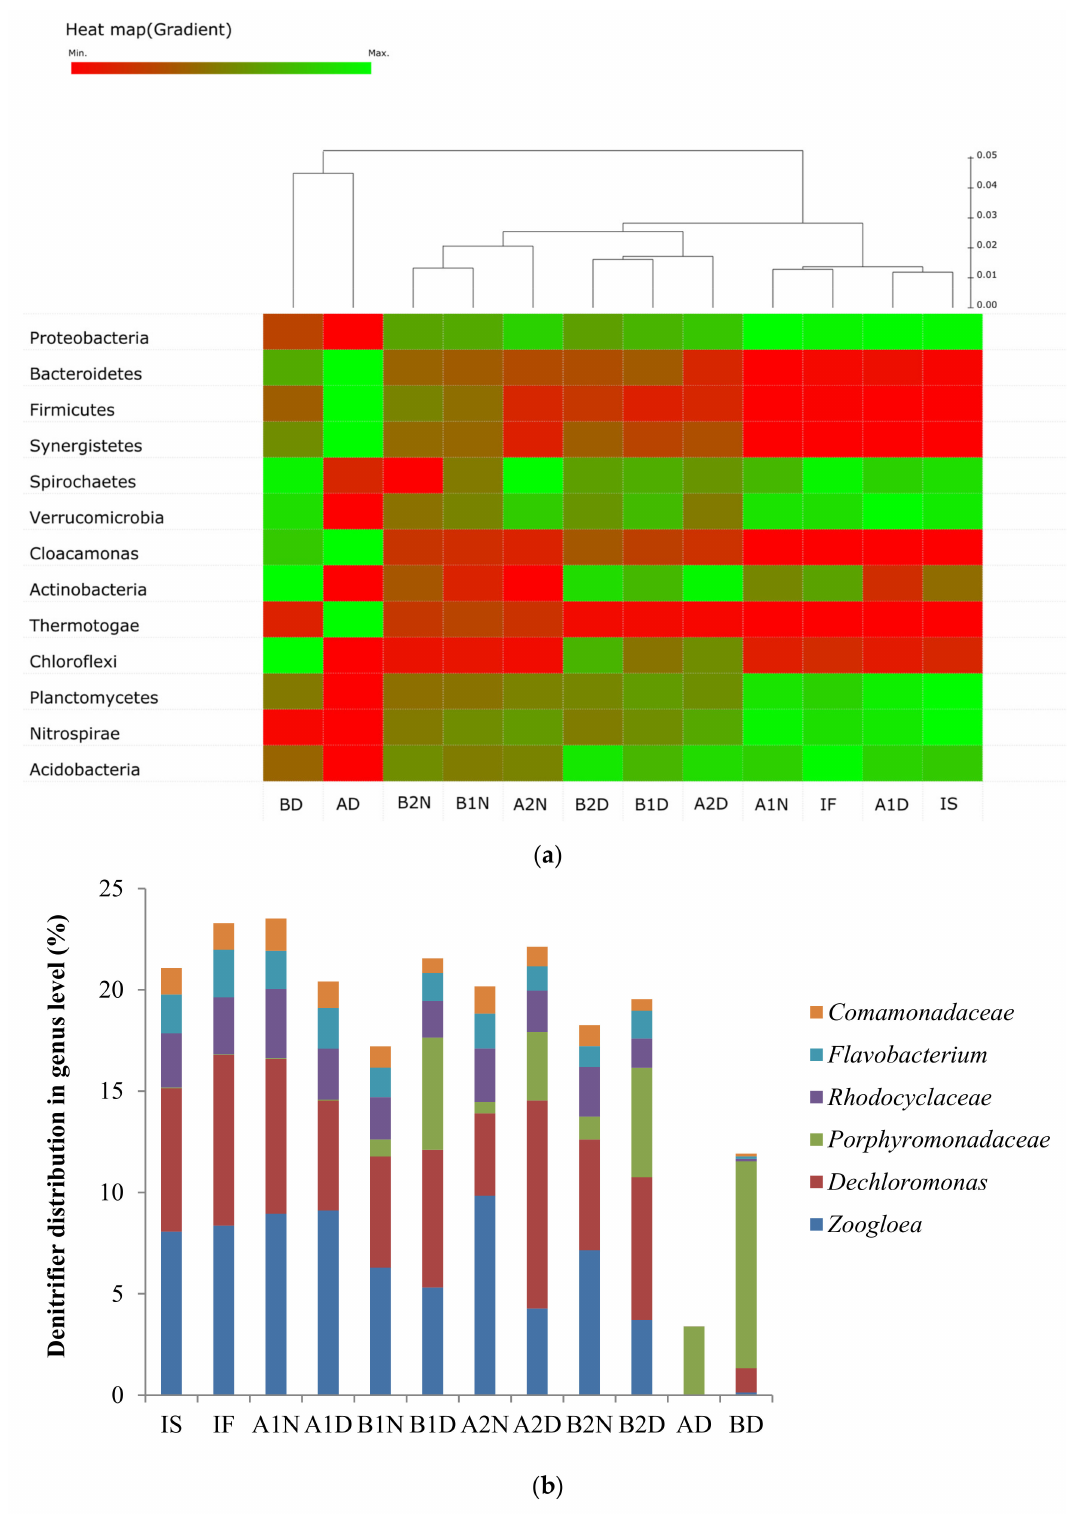
Figure 5. The dynamics of microbial communities shown as ( a ) heat maps of the relative abundance of bacteria at the phylum level and ( b ) denitrification-related bacteria (denitrifiers) identified at the genus level. A and B indicate acetate and butyrate, respectively, and N and D represent nitrification and denitrification, respectively. Initial sludge (IS) microbial communities were compared to those in final nitrification samples